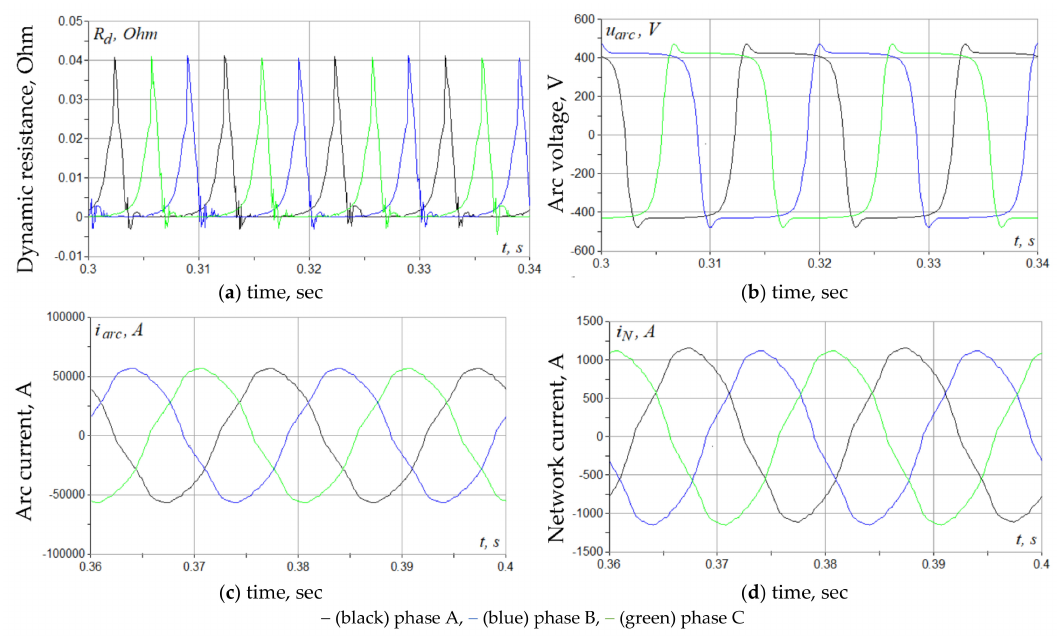
Figure 12. Dynamic arc resistance ( a ), instantaneous values of arc voltages ( b ), instantaneous values of arc currents ( c ), instantaneous values of mains currents ( d ) in steady state for arc length 20 mm. Increasing the length of the arc also leads to a deterioration of the shape of the current in the arc supply circuit and the shape of the current (Figure 12c) consumed from the mains (Figure 12d). The results of calculation of the steady asymmetric mode in the power supply system of arcs for different values of arc length in phases: phase A—2 mm, phase B—8 mm, phase C—20 mm are shown in Figure 13.